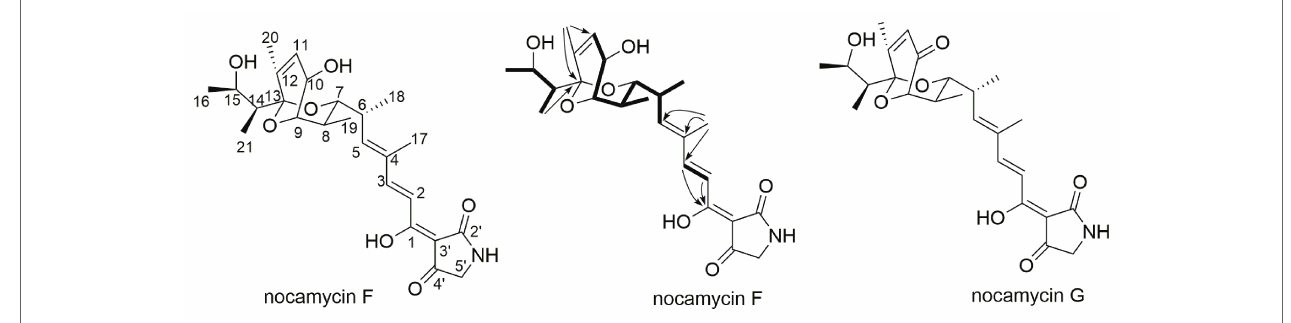
FIGURE 4 | The structures of nocamycin F and nocamycin